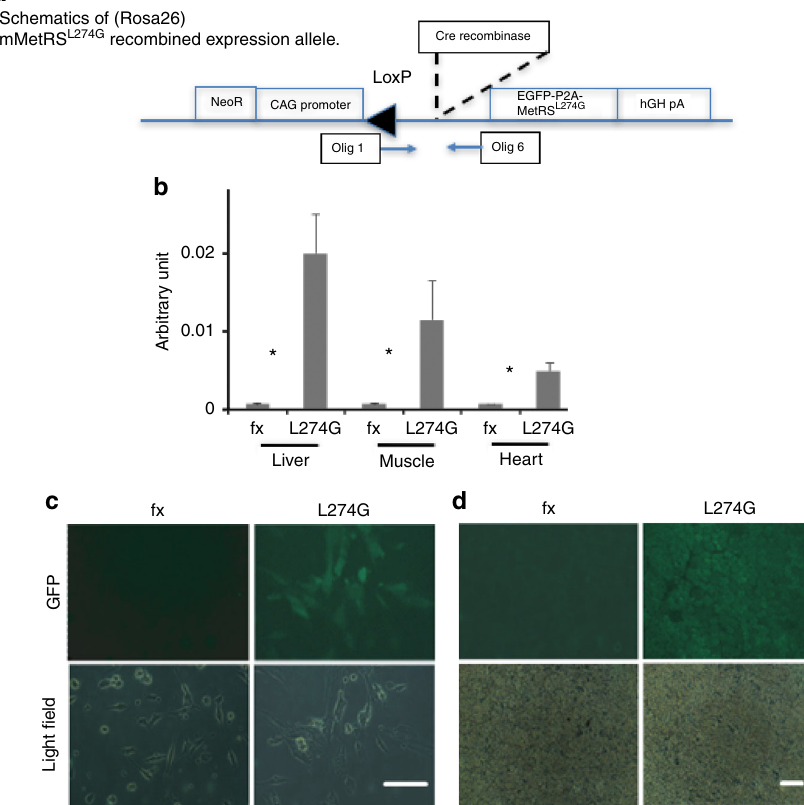
Fig. 1 The expression of GFP-tagged MetRS L274G upon ‘ Stop signal ’ excision. a Schematic representation map of the allele after CMV-Cre mediated ‘ Stop signal ’ excision (MetRS L274G mice). b QT PCR demonstrates that transgene expression is indeed induced upon Cre-LoxP mediated excision of the ‘ STOP ’ signal. * P < 0.05, Wilcoxon rank sum test. s.e.m., n = 3 for each genotype. c Cells were isolated from indicated genotypes and cultured in F10, 20% FBS for 24 h after which the cells were imaged on bright fi eld and for GFP fl uorescence. d Muscles from three separate mice were dissected, cryo-sectioned and imaged on bright fi eld and for GFP fl uorescence. 3 – 4 experimental replicates (sections) were assayed for each animal. Representative images are shown. Scale bar , 100 μ